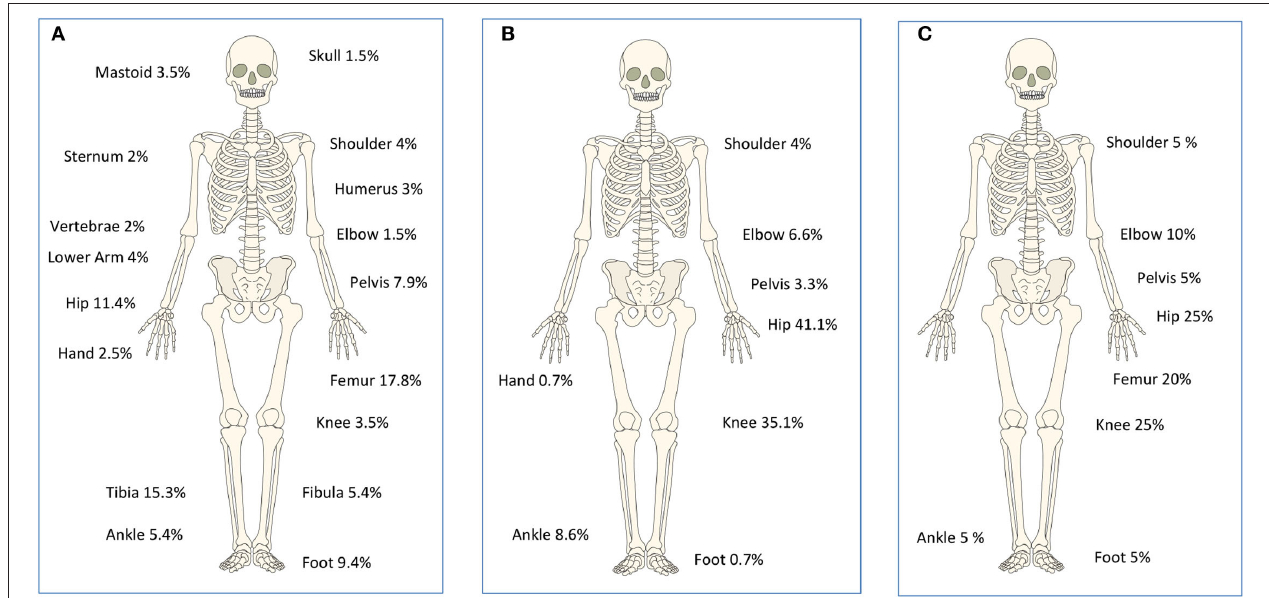
FIGURE 2 | Anatomical locations affected in OM (A) SA (B) and OM + SA (C) . Cases with unknown locations: OM ( n = 16), SA ( n = 9) and OM + SA ( n = 3). Cases with multifocal locations: OM ( n = 9), SA ( n = 3). This work “human bones” is a derivative of “Human bones.svg” taken from https://klexikon.zum.de/wiki/Datei: Human_bones.svg by Kazukiokumura used under CC by Andreas Trobisch.